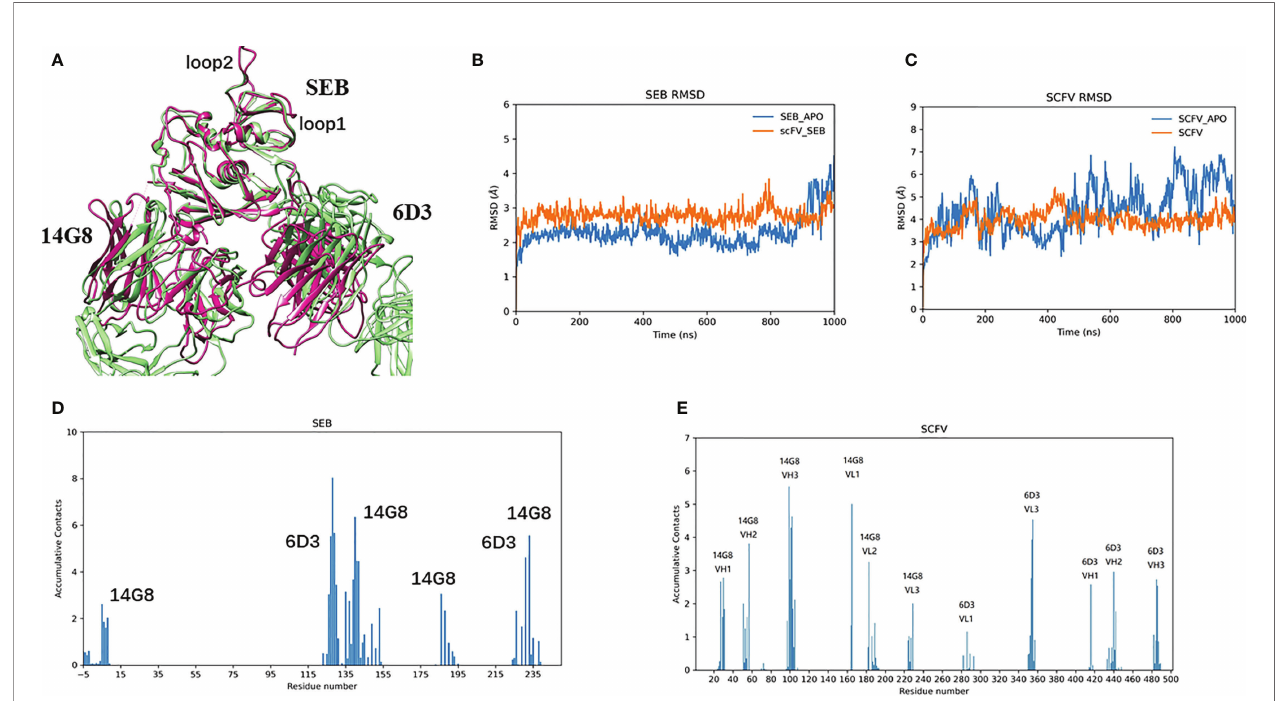
FIGURE 3 | MB102a scFV from stable complex with SEB. (A) Superimposing of SEB from fi nal snapshot (1000 ns) of the scFV-SEB with that in the PDB 4RGB structure. (B, C) are RMSD trajectories of SEB and MB102a scFV, respectively. The contact frequencies of SEB (D) with MB102a scFV (E) are